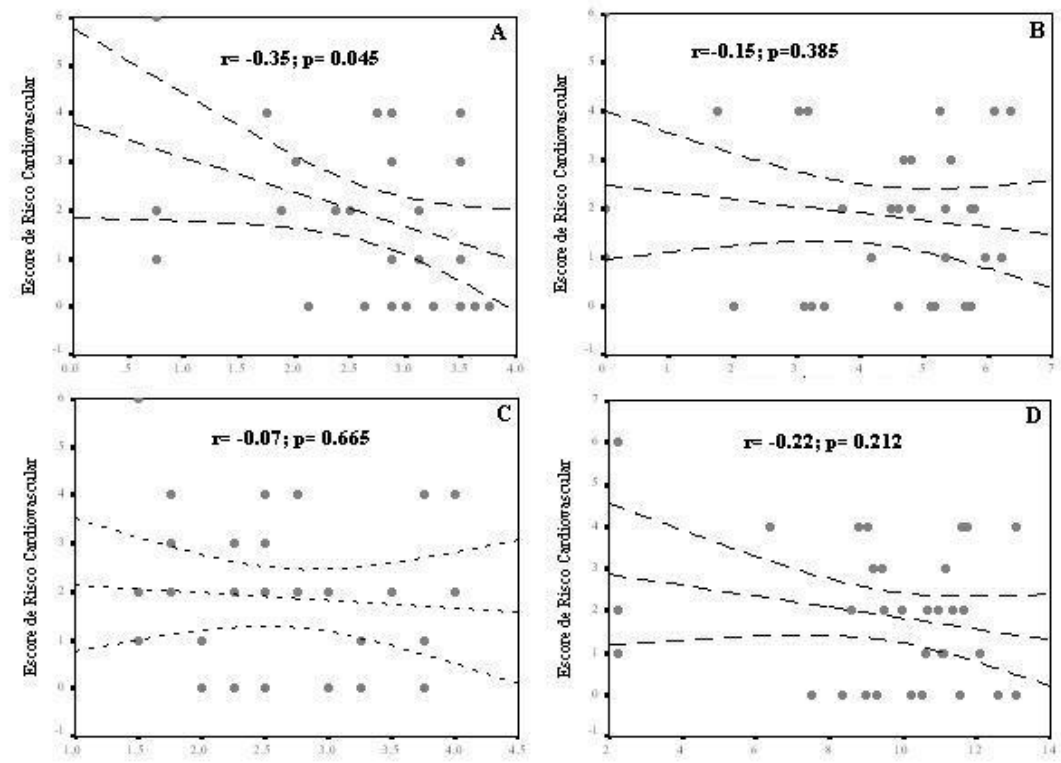
Figura 1. Relacionamento entre diferentes domínios da prática de atividade física (A) Trabalho, (B) Esporte, (C) Tempo Livre e (D) Total com indicadores de risco